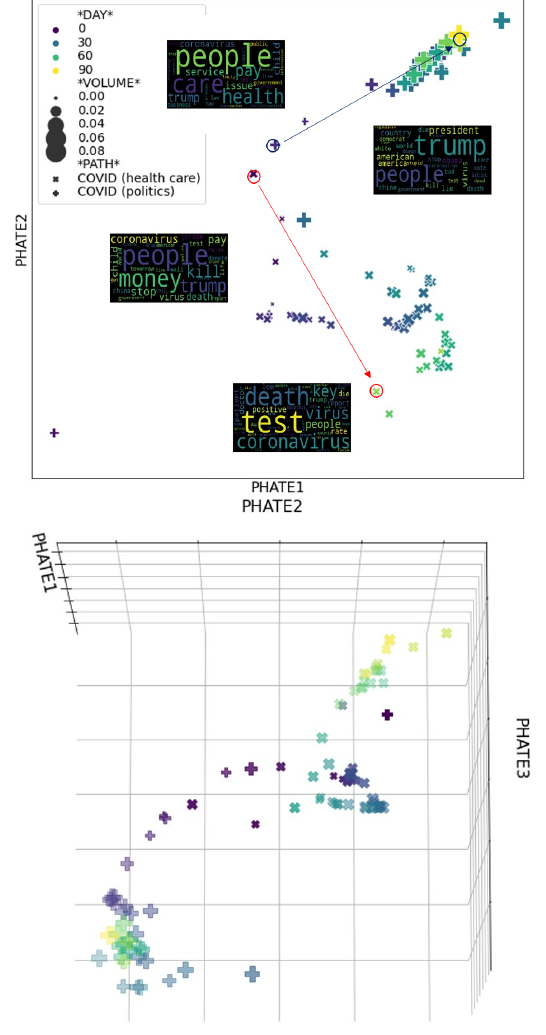
Figure 7. Potential of heat-diffusion for affinity-based transition embedding (PHATE) for subsets of topics in the COVID cluster. The plots demonstrate a 2D (top) and a 3D (bottom) embedding of two different paths (i.e., health care and politics). Colors and sizes highlight time and tweet volumes, respectively. Here four word clouds containing top 30 words in corresponding topics are shown for the time points (with arrows connecting the beginning and the end topics on the same path) highlighted by red (health care) and black (politics) circles. Note the plots show divergent behavior of public discourse around COVID-19, where two similar discussions diverge to different discussions (indicated by the word clouds). The 3D embedding illustrates nonlinear paths, that is, spirals and loops, for this